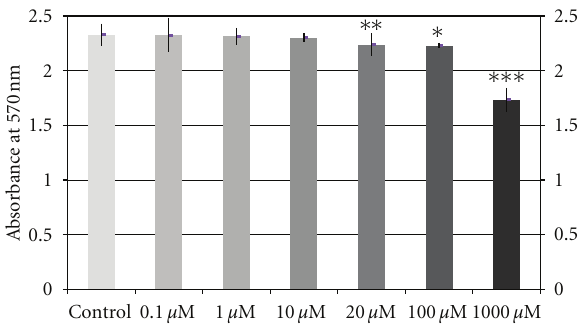
Figure 1: E ff ects of di ff erent aspirin doses (0.1 μ M, 1 μ M, 10 μ M, 20 μ M, 100 μ M, or 1000 μ M) on osteoblast proliferation in MG-63 cell line after 24h of incubation. Data are expressed as means + SEM. We compared data between each treatment and control culture by analysis of variance (ANOVA) test. ∗ P = 0 . 023, ∗∗ P = 0 . 014, ∗∗∗ P = 0 .